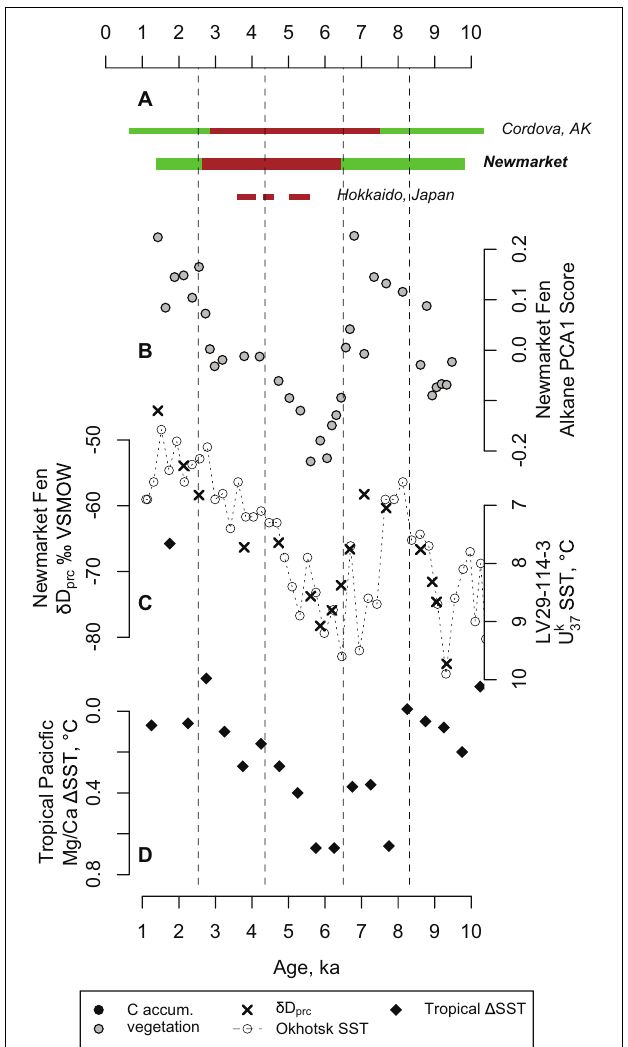
FIGURE 5 | (A) : Summary of wet (green) and dry (brown) periods at Newmarket Fen, Alaska (Jones et al., 2009; Nichols et al., 2014; Peteet et al., 2016) and Hokkaido (Ishii et al., 2016, 2017); (B) Vegetation change as indicated by the first principal component of leaf wax n-alkane abundances; (C) δ D of peatland water at Newmarket and alkenone-based SST in the sea of Okhotsk (Max et al., 2012); and (D) the tropical SST gradient across the tropical Pacific Ocean based on Mg/Ca SST estimates in the west and east (Koutavas and Joanides, 2012).